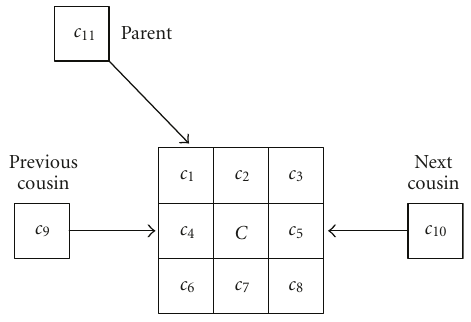
Figure 20: Context modeling